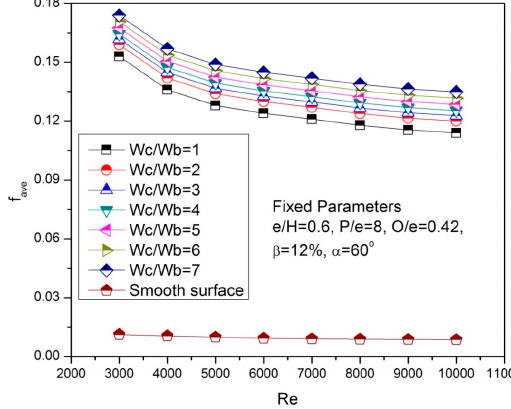
Figure 9. Variation of friction factors ( f ave ) with respect to the Reynolds number.